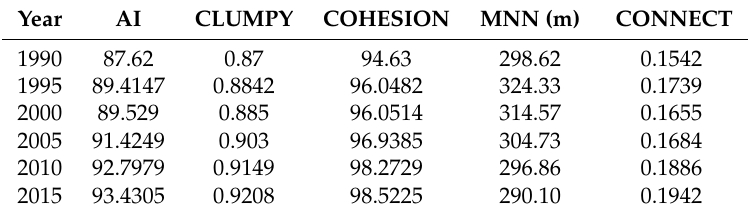
Table 5. Landscape structure indexes and their changes in rural residential areas in